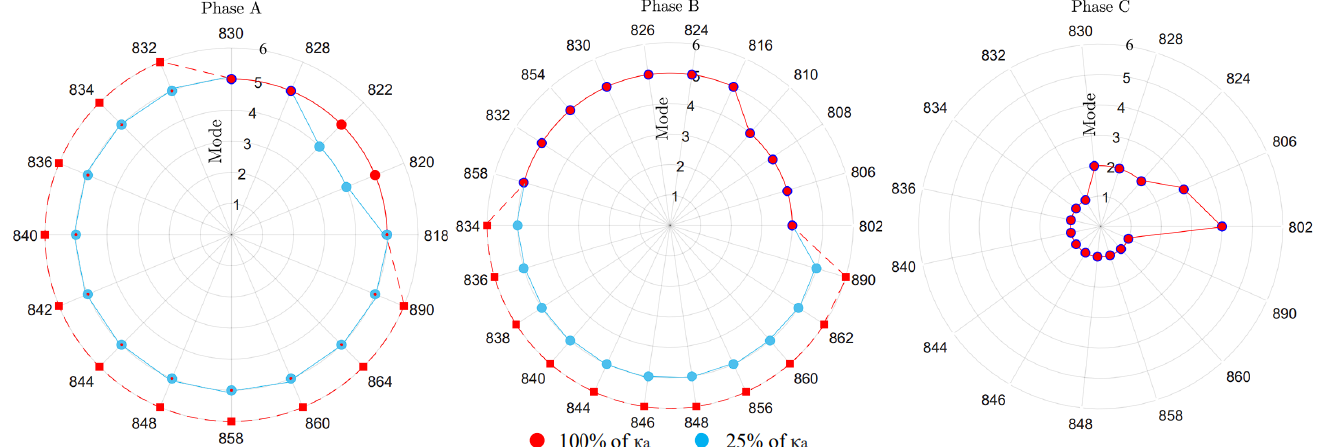
Figure 15. Operation modes using the proposed method for single-phase fault in phase C.